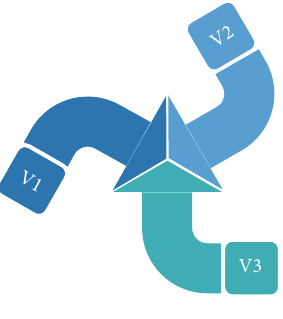
Figure 1: Bayesian network G. Table 1: Conditional probability table of node V 1 .